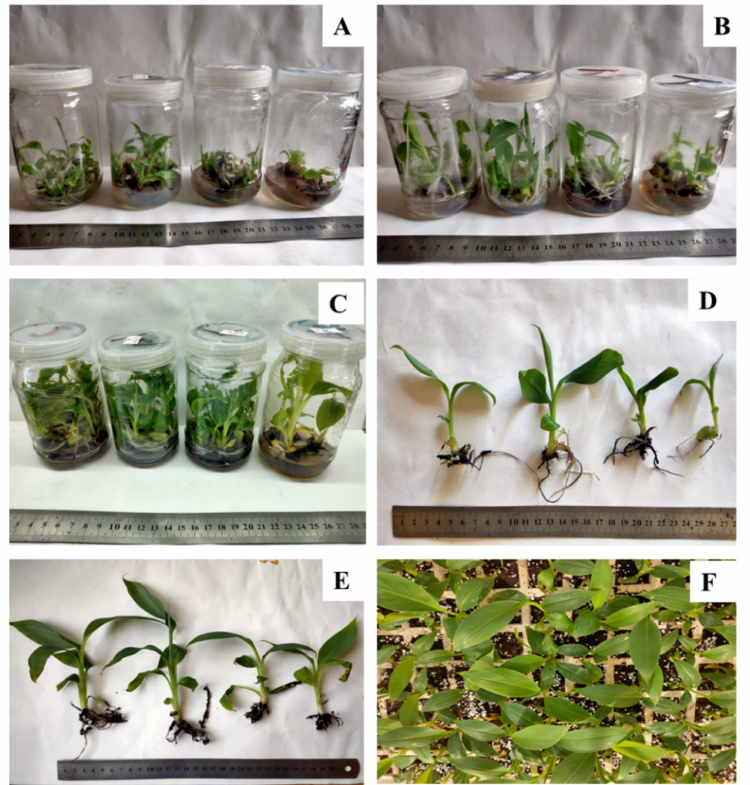
Figure 2. Effect of copper sulphate on in vitro propagation and the acclimatization of banana